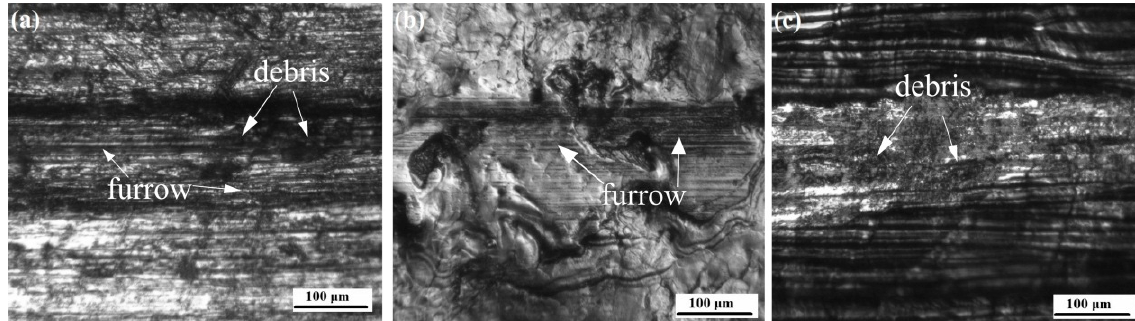
Figure 9. Worn surfaces of ( a ) base Ti substrate, ( b ) Ti–Ta alloy formed by a beam power of 1250 W, ( c ) Ti–Ta alloy formed by a beam power of 1750 W.